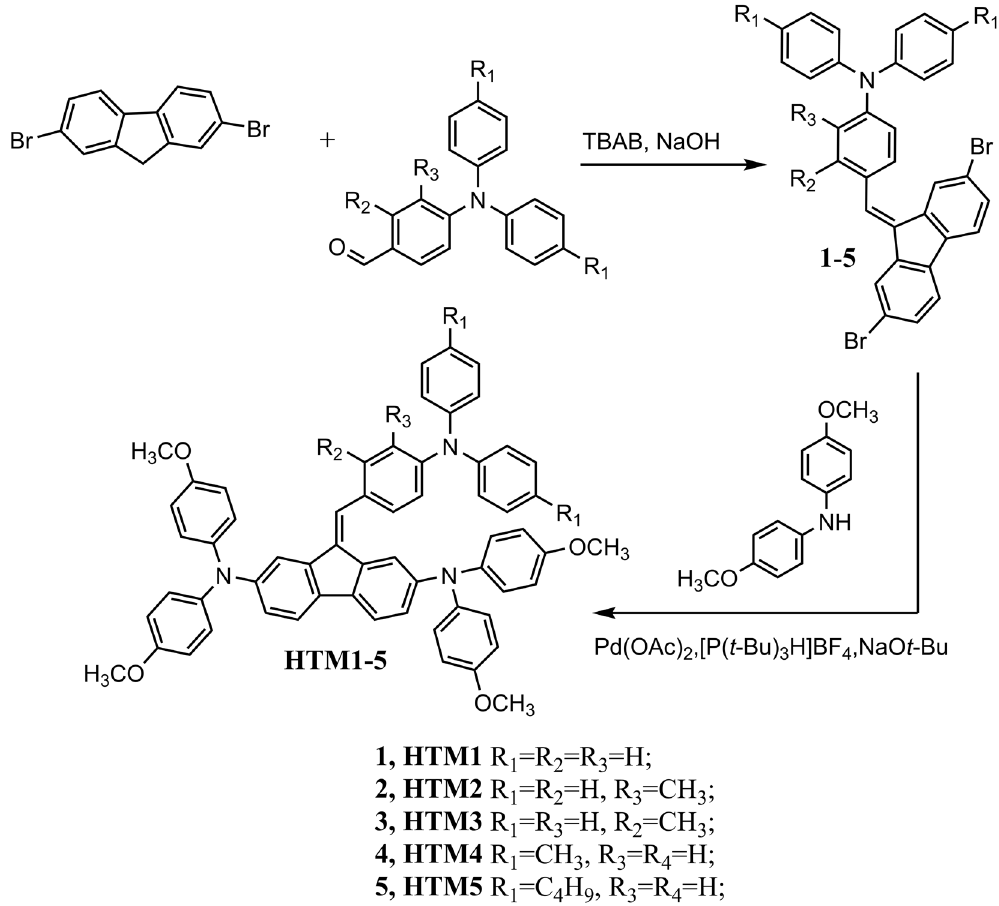
Figure 2. Synthetic route to hole transporting materials HTM1–5